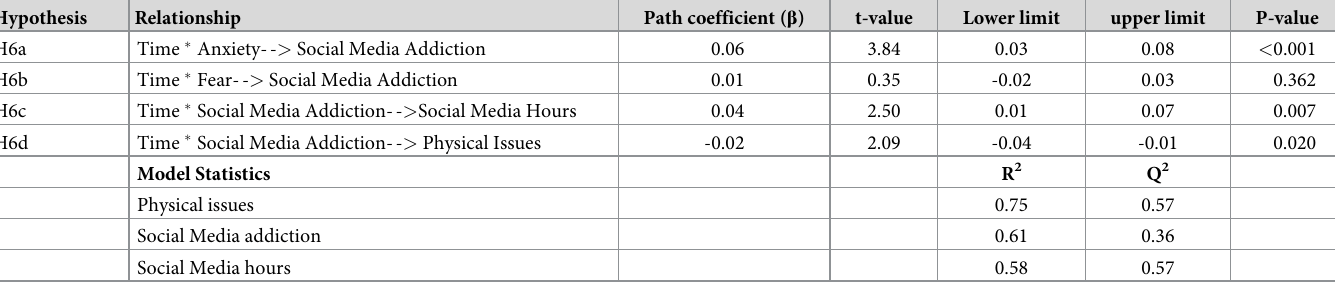
Table 3. Hypothesis testing, path coefficients and their 95% Confidence Intervals (CIs) for time